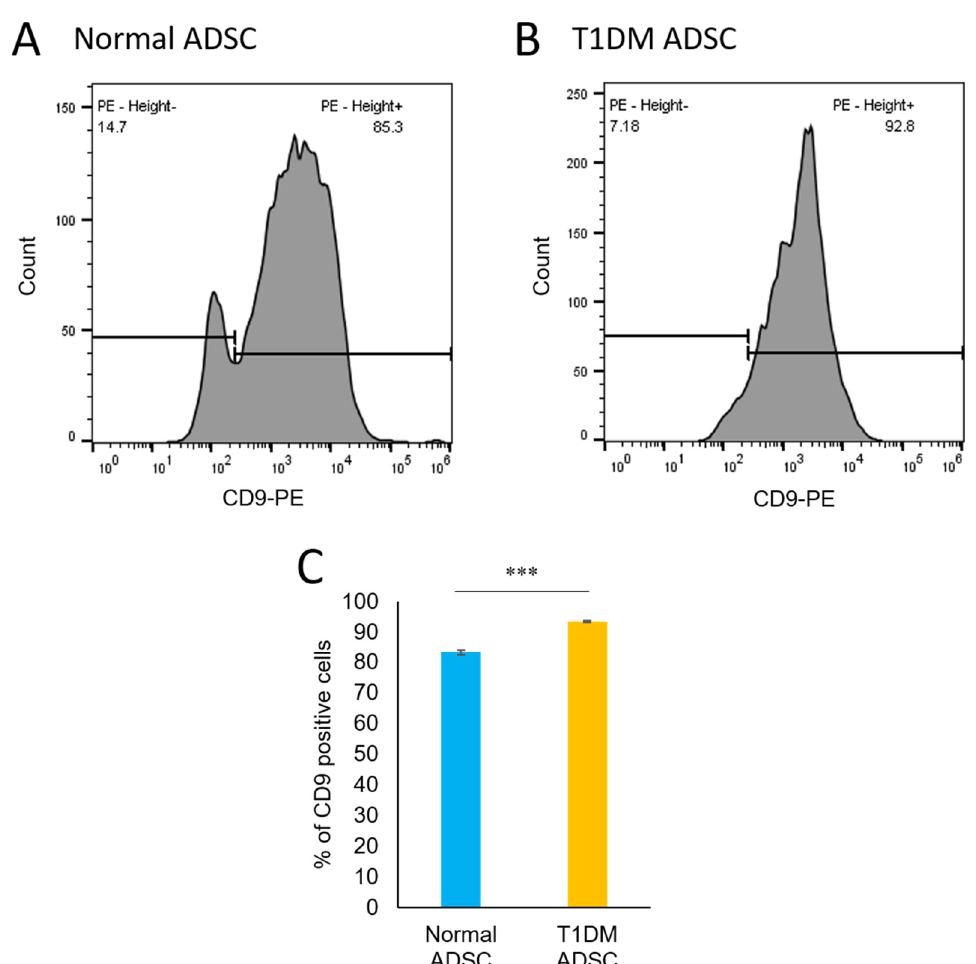
Figure 6. Characteristics evaluation of exosomes in stem cells. Results of flow cytometric determination of percentages of CD9-positive exosomes in the exosomes extracted from ADSCs by conjugation with the exosome marker CD63. (A) Histogram of PE-labeled CD9 flow cytometry for normal ADSCs. (B) Histogram of PE-labeled CD9 flow cytometry for T1DM ADSCs. (C) Results of quantification of the percentages of positive cells. Values shown in the graph are in the form of mean ± SEM. The number of samples is n = 3. Two independent evaluations were performed. Shapiro–Wilk and unpaired t-tests were used for statistical analysis. *** The p -value was 0.0006.